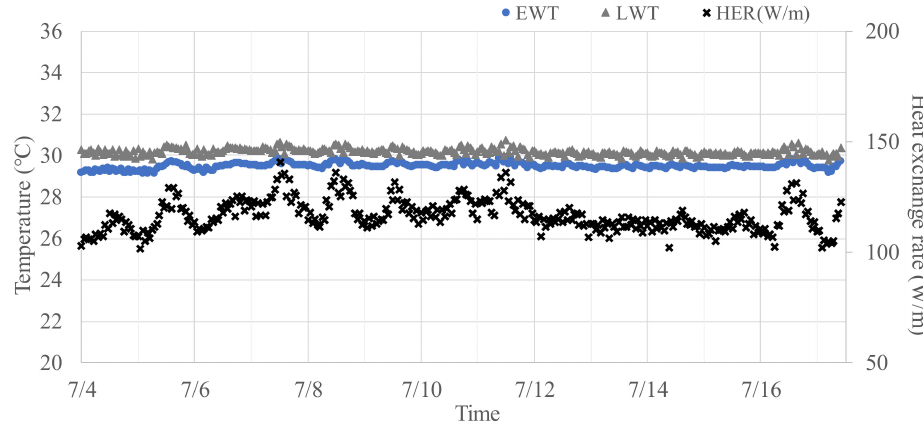
Figure 14. Fluctuation of EWT, LWT, and HER in Case 6. The average rate of heat exchange was 102.6 W/m at 30 LPM and 116.8 W/m at 80 LMP, the temperature difference between EWT and LWT being 2.3 ◦ C and 0.8 ◦